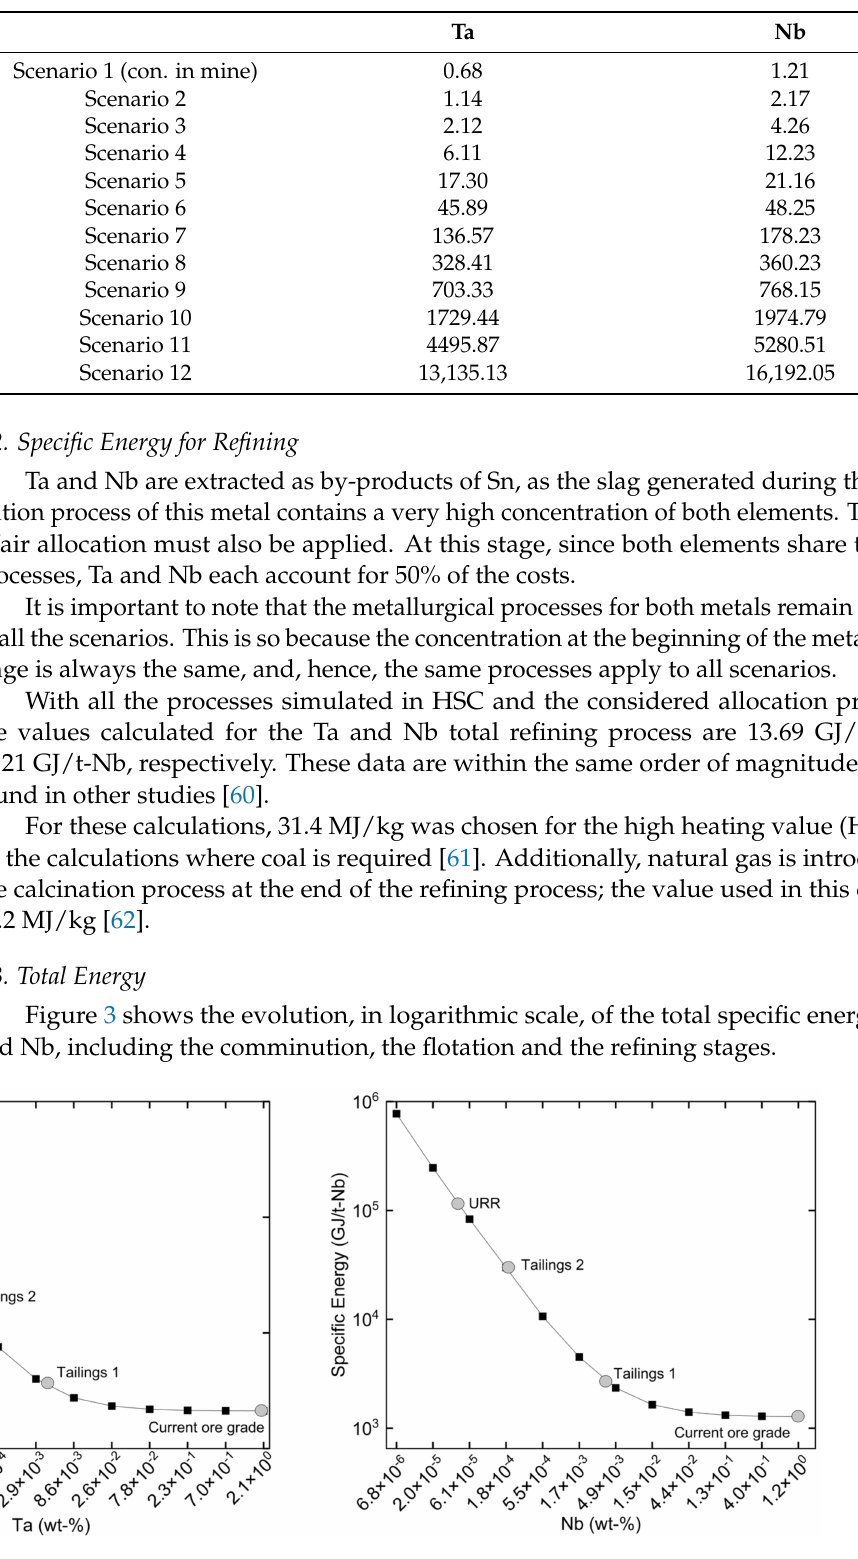
Figure 3. Specific energy for concentration for Ta ( left ) and Nb ( right ). In both cases, the Y axis is in log scale. For the sake of clarity, the points representing the scenarios have been joined to form a continuous